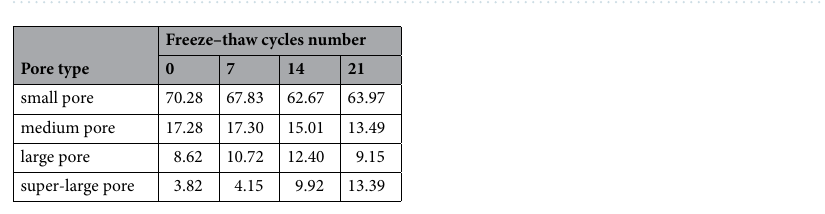
Table 2. Pore size distribution of sandstone under different freeze–thaw cycles (%).